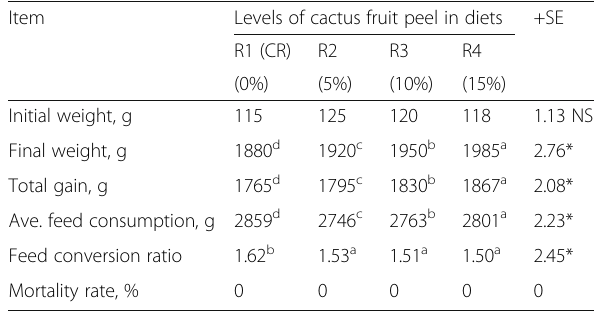
Table 3 Productive of commercial Cobb broiler fed diets containing different levels of prickly peel Item Levels of cactus fruit peel in